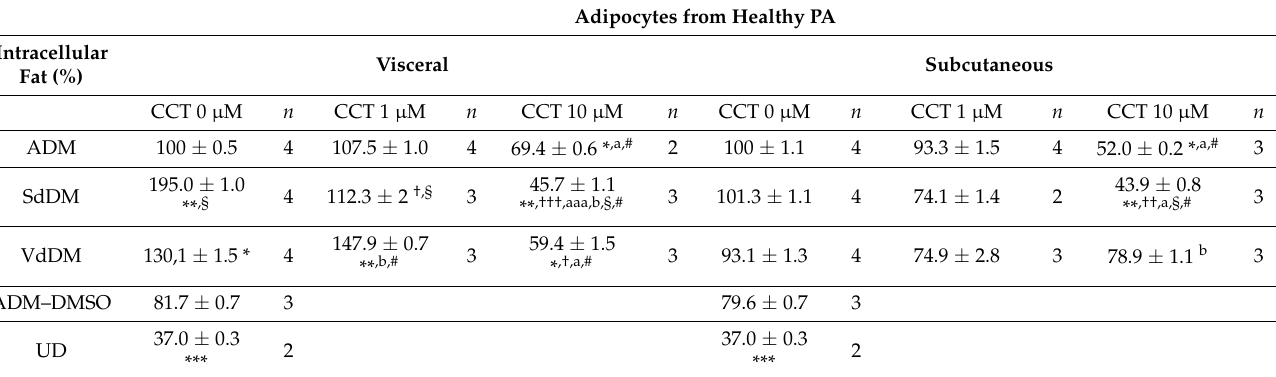
Table 4. Summary of intracellular fat